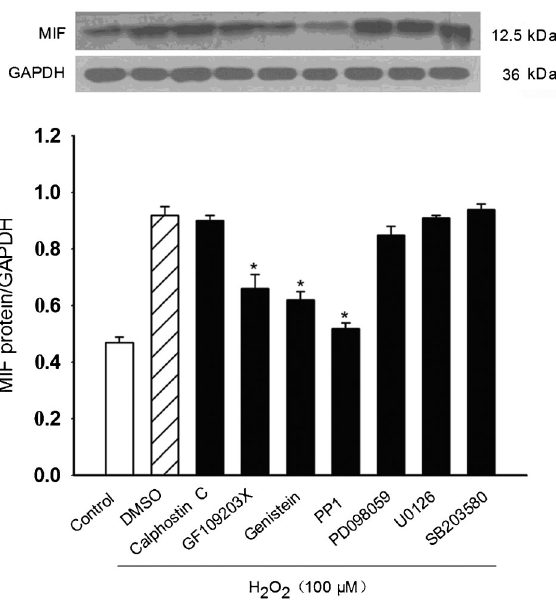
Figure 4. Effects of various inhibitors on H 2 O 2 -induced migration inhibitory factor (MIF) production in HL-1 cells. After HL-1 cells were pretreated for 1 h with 0.1% DMSO (control), calphostin C (100 nM), GF109203X (5 m M), genistein (10 m M), PP1 (10 m